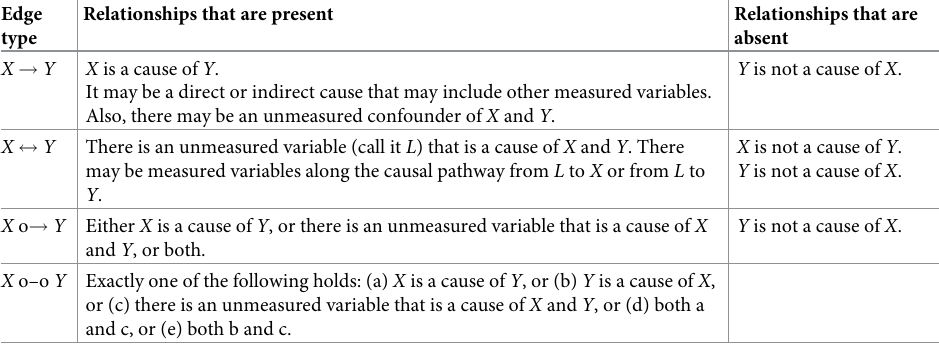
Table 2. A description of the edge types in a PAG and their causal